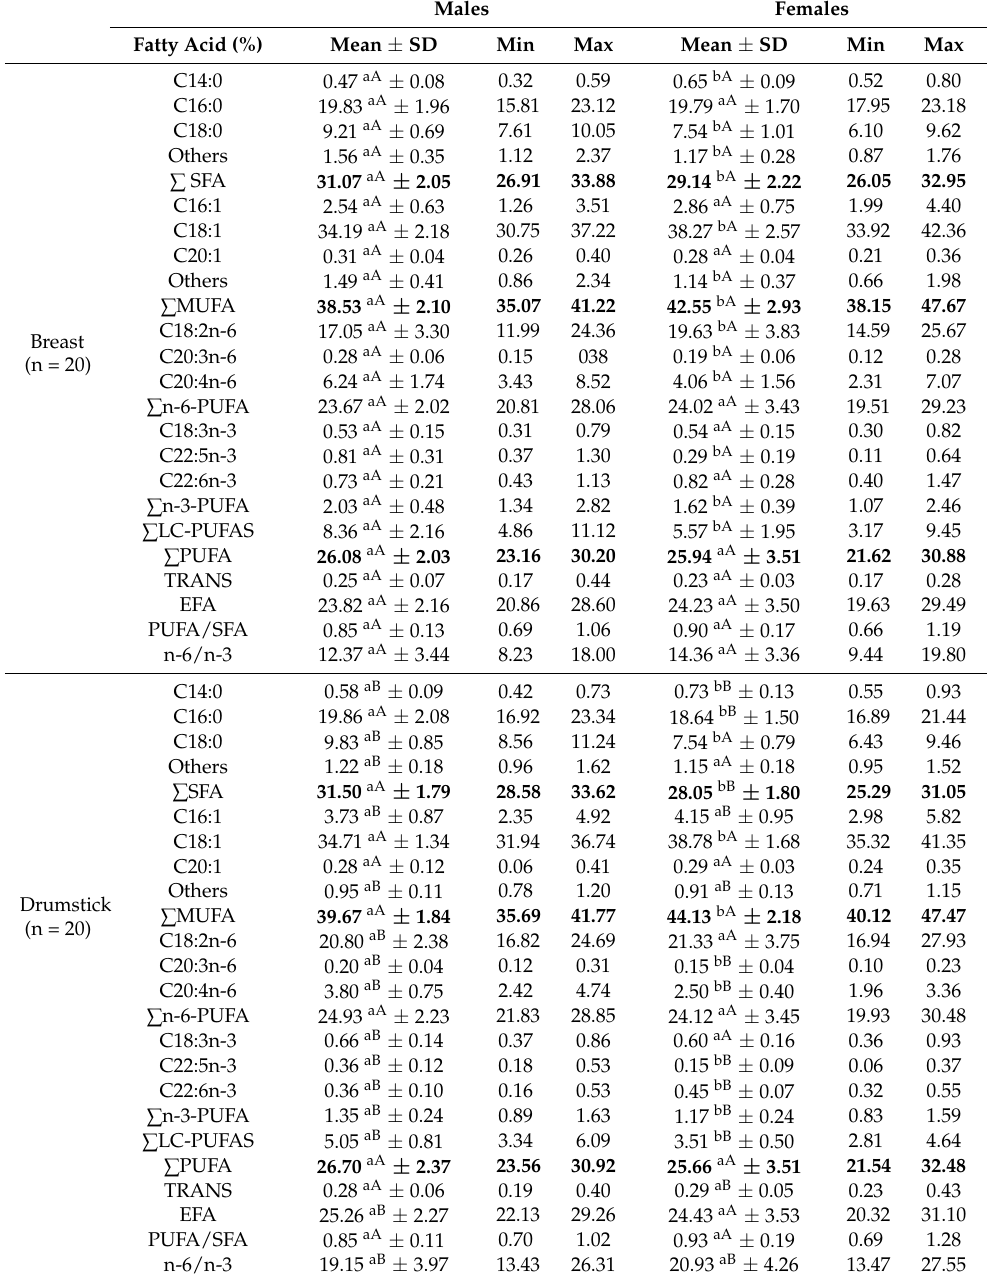
Table 4. Fatty acid profile of the breast and drumstick meat of males and females of the “Branca” breed (mean ± SD, Min and Max) (results expressed as % of total fatty